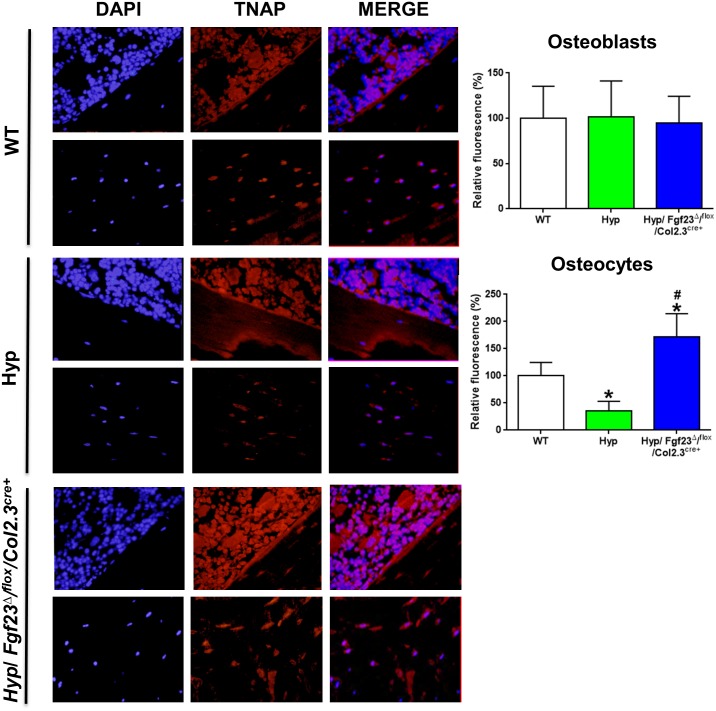
Bone specific deletion of Fgf23 rescues suppressed TNAP activity in Hyp mice.Histochemical TNAP staining in bone sections from WT, Hyp, and Hyp/Fgf23
Δ/flox
/Col2.3
cre+ mice and quantification of relative fluorescence in osteoblasts and osteocytes. Top panels for each genotype represent endocortical bone surface, bottom panels cortical bone. Each data point is the mean ± SD of at least four mice. Individual values are given in S1 Data. *, p < 0.05 versus WT; #, p < 0.05 versus Hyp.